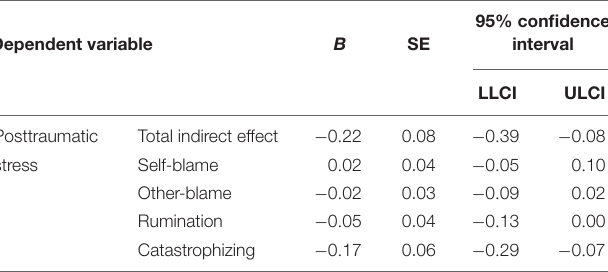
TABLE 3 | Bootstrapping analysis for indirect effect of maladaptive emotion regulation